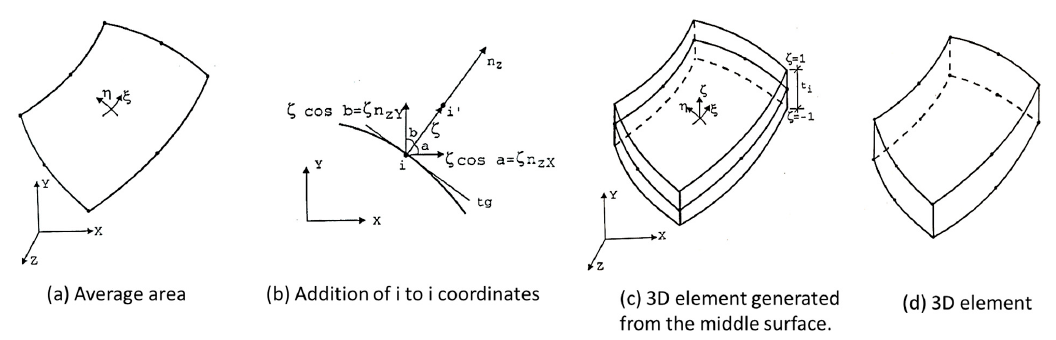
Figure 26. Curved element. Reproduced with permission [75] .